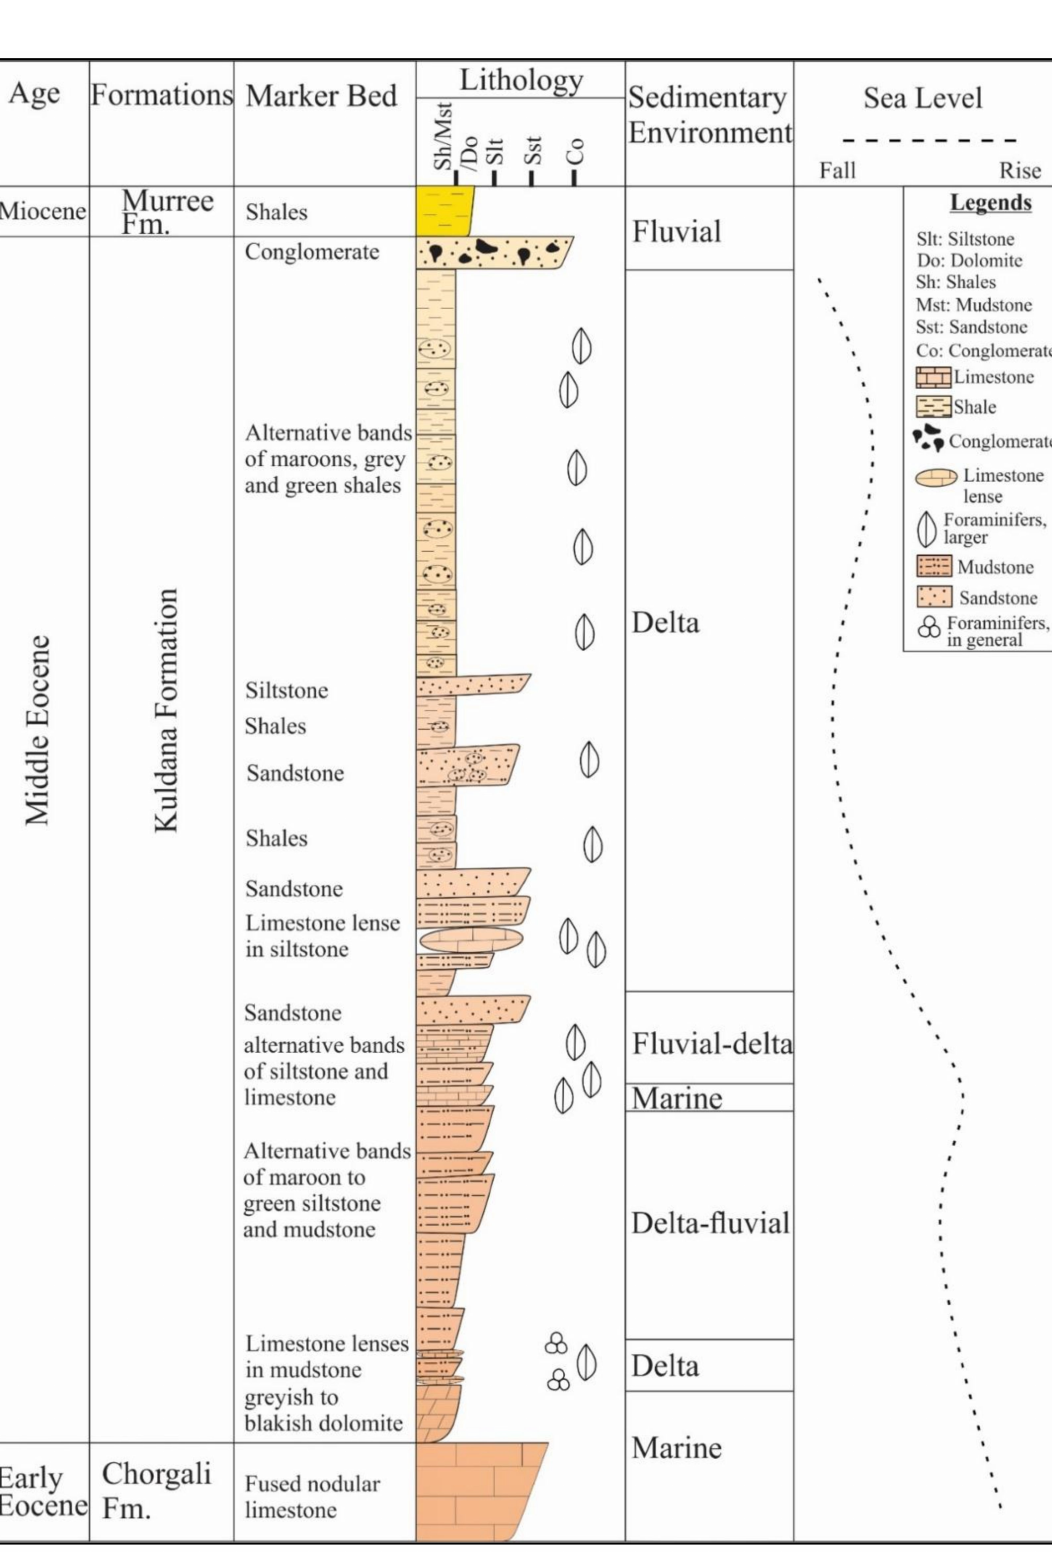
Figure 5. Log displaying the Yadgaar section lithology of the Kuldana Formation from the Muzaf- farabad